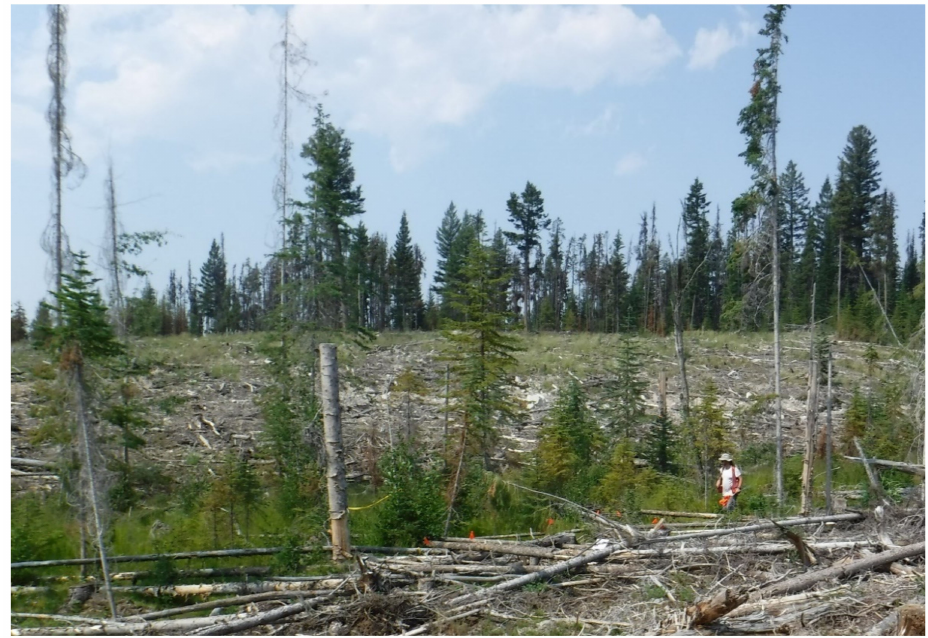
Figure 11. Linear windrow of woody debris to protect logged riparian area from